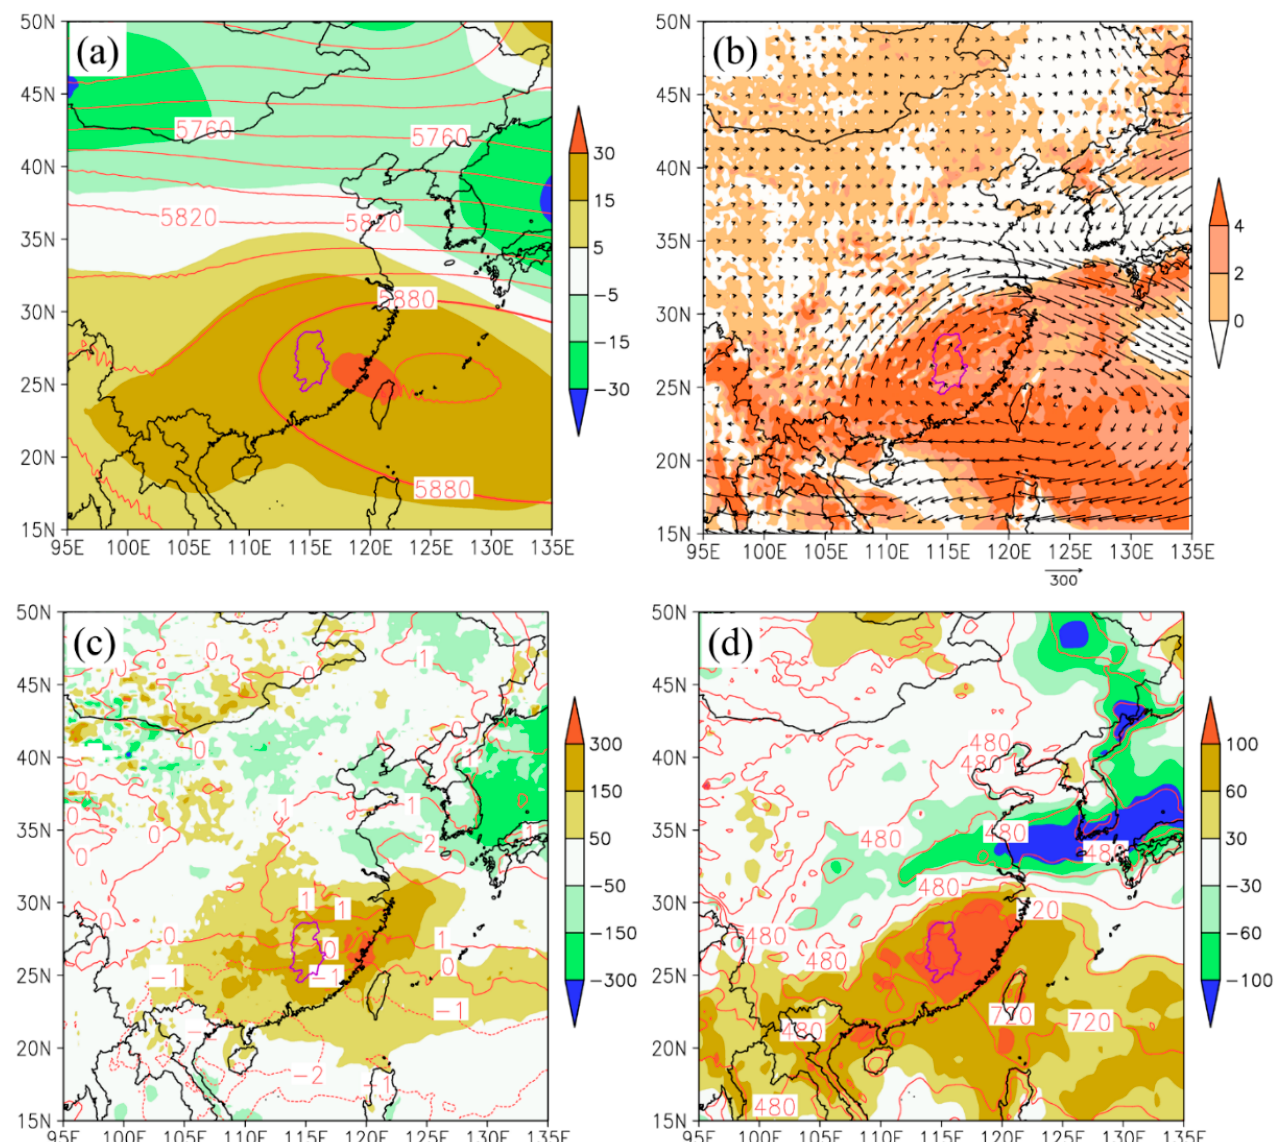
Figure 16. Spatial patterns of ( a ) the 500 hPa geopotential height (contour, gpm) and its anomalies (shaded, gpm), ( b ) integrated layer water vapor flux anomalies (vector, kg·m − 1 ·s − 1 ) and divergence anomalies (shaded, 10 − 5 kg·m − 2 ·s − 1 ), ( c ) convective inhibition (shaded, J·kg − 1 ) and total cloud cover anomalies (contour, 0–10 tenths), and ( d ) surface net solar radiation (contour, MJ/m 2 ) and its anomalies (shaded, MJ/m 2 ) for July 2003. The anomaly values for July 2003 are relative to July 1961–2018.